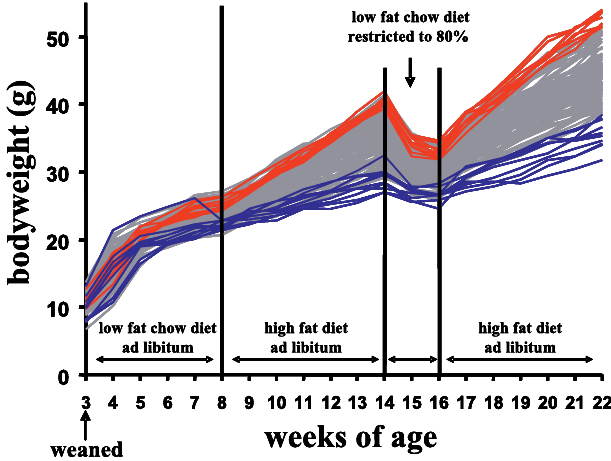
Figure 2. Stability of the Adiposity Phenotype in B6 Mice Male mice ( n ¼ 107) were fed a low-fat chow diet (Picolab 5053) from weaning to 8 wk of age, a high-fat diet (Research Diets D12331) from 8– 14 wk, then the low-fat chow diet, restricted to 80% of the amount consumed from wk 7–8, during wk 15 and16, and finally, the high-fat diet for wk 17–22. Mice were weighed weekly except during the food restriction period when body weights were measured daily until they had stabilized under these conditions. Food intake was measured weekly starting from wk 7. At the end of wk 8, 14, 16, and 22, the body composition of each mouse was analyzed by NMR. The body weight curves of mice at the upper and lower 10% of the frequency distribution at 22 wk of age are plotted in red and blue. DOI: